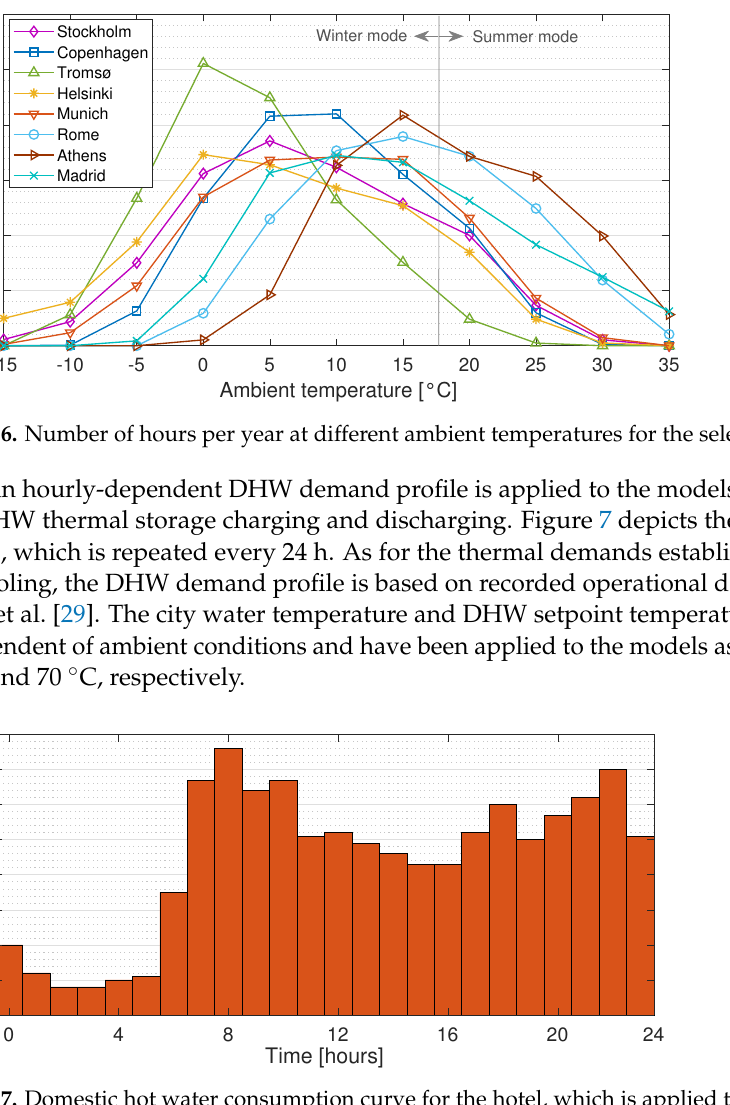
Figure 7. Domestic hot water consumption curve for the hotel, which is applied to the